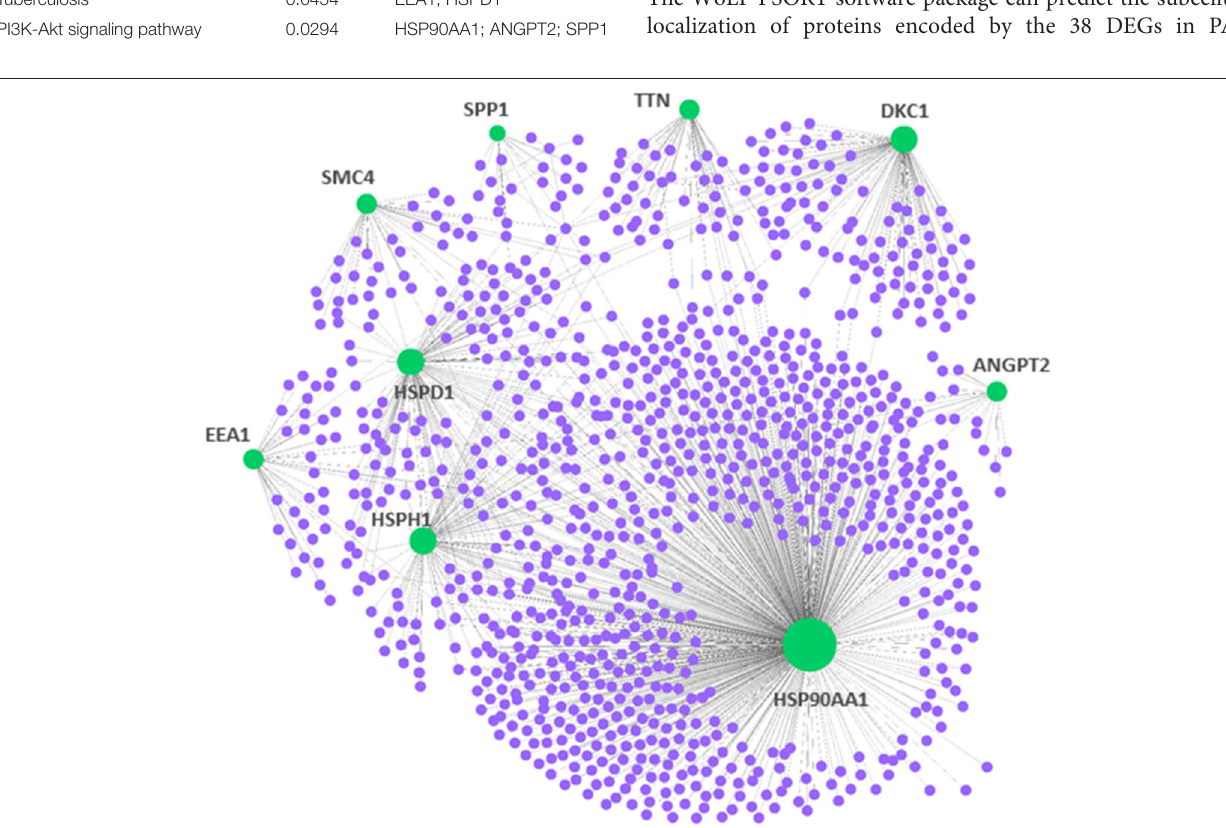
FIGURE 2 | Protein–protein interaction network for the DEGs in pulmonary arterial hypertension (PAH). The nodes indicated the DEGs, while the edges indicated the interactions between different proteins. The medium confidence score was performed to construct the Protein–protein interaction (PPI) networks.